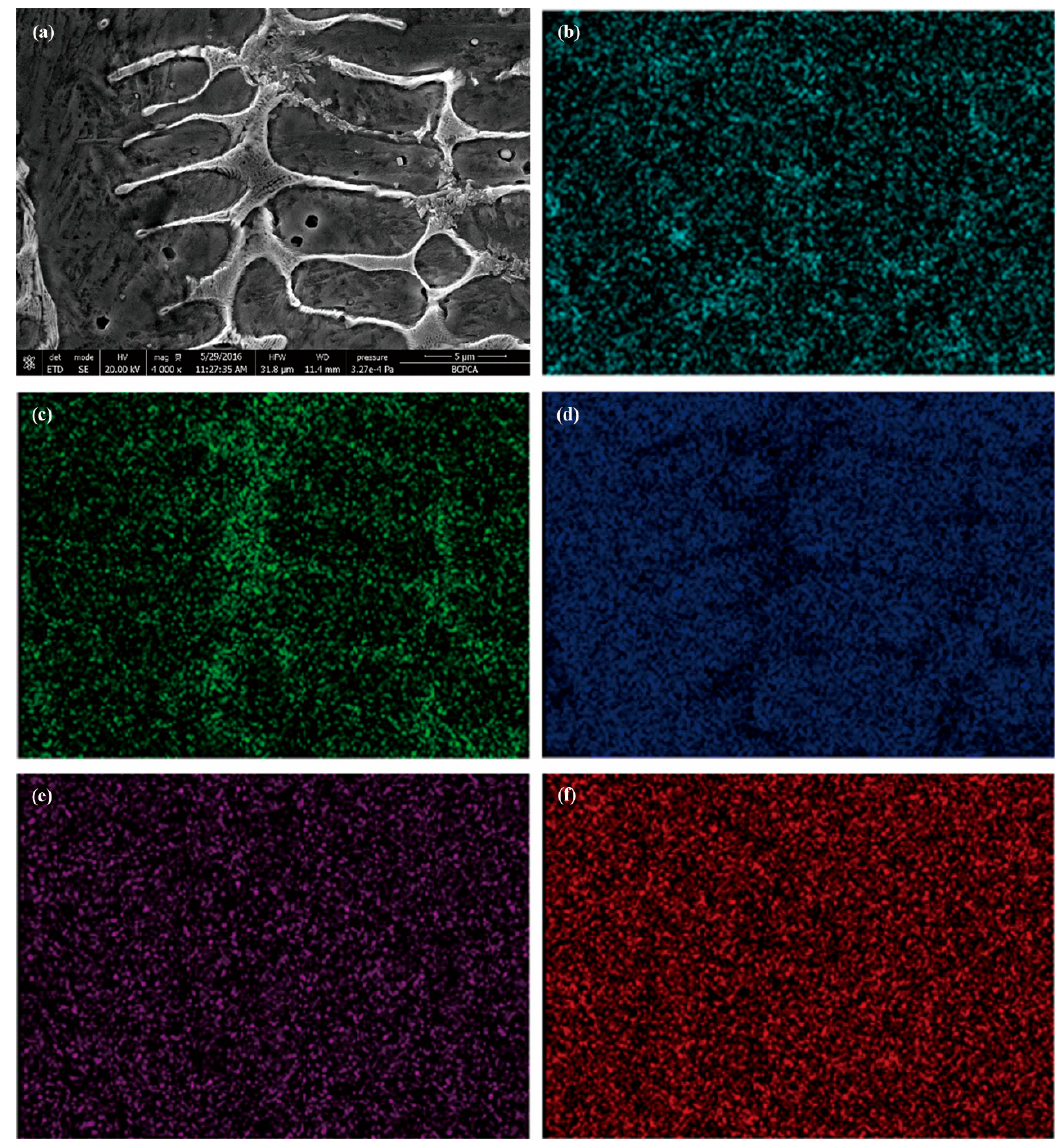
Figure 8. The EDS surface scan result: ( a ) SEM photo; ( b ) C; ( c ) Cr; ( d ) Fe; ( e ) Ni; ( f ) Si.